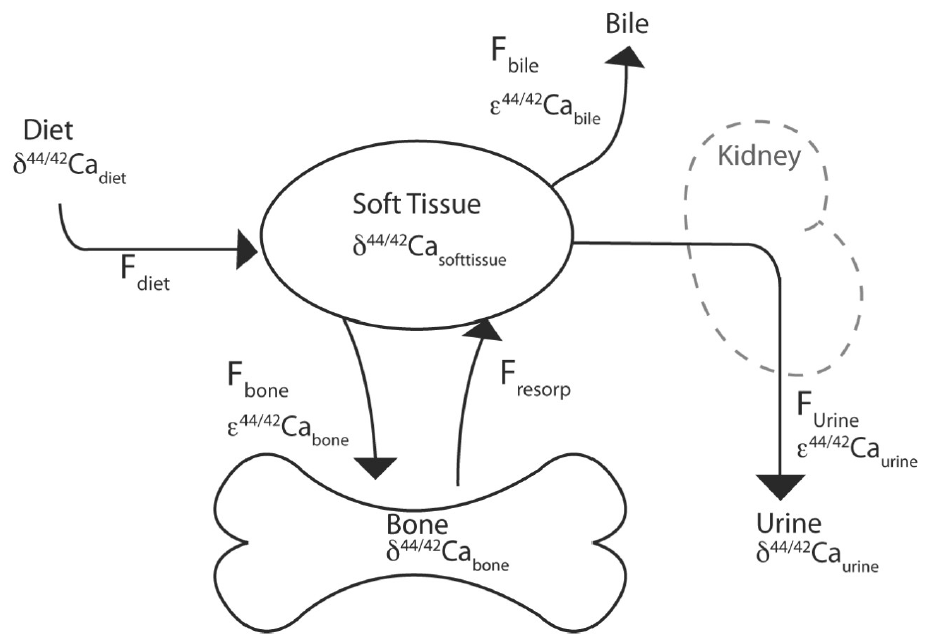
Figure 2. Schematic of model pools and fluxes used to quantify bone loss. F is the flux diet of calcium absorbed from diet, F and F are the bone formation and resorption bone resorp fluxes, and F and F are the net excretion fluxes of calcium through urine and bile urine bile respectively.  44/42 Ca and δ 44/42 Ca are the Ca isotopic compositions of the soft tissue soft bone and bone pools, δ 44/42 Ca and δ 44/42 Ca are the isotopic compositions of the fluxes of diet urine Ca absorbed from diet and excreted in urine, and ε 44/42 Ca ε 44/42 Ca and ε 44/42 Ca are bone, urine, bile the isotopic variations associated with forming bone, urine, and bile, respectively, from the soft tissue pool. Note: This figure is adapted with permission from [27], Copyright © 2012 National Academy of